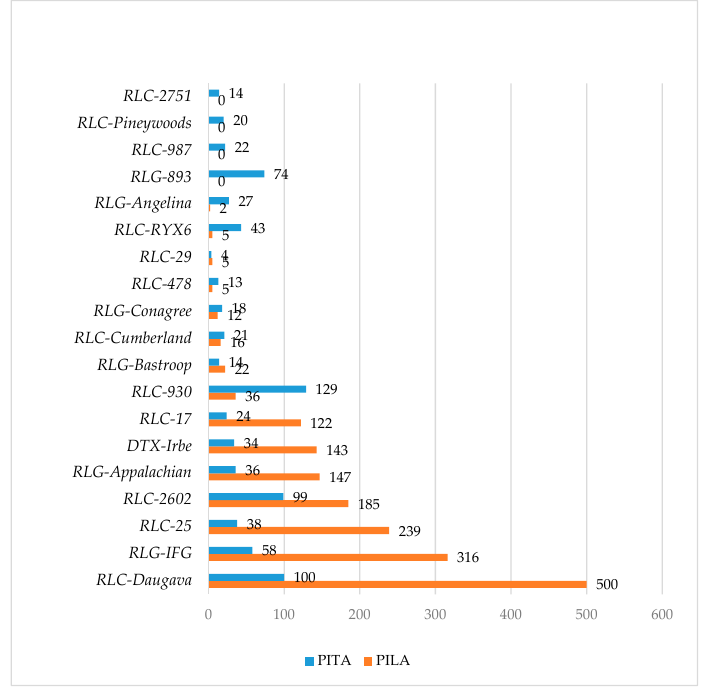
Figure 2. Distribution of >1 kb hits to TEs in gene introns of filtered P. taeda (PITA) genes and high-quality P. lambertiana (PILA) genes.